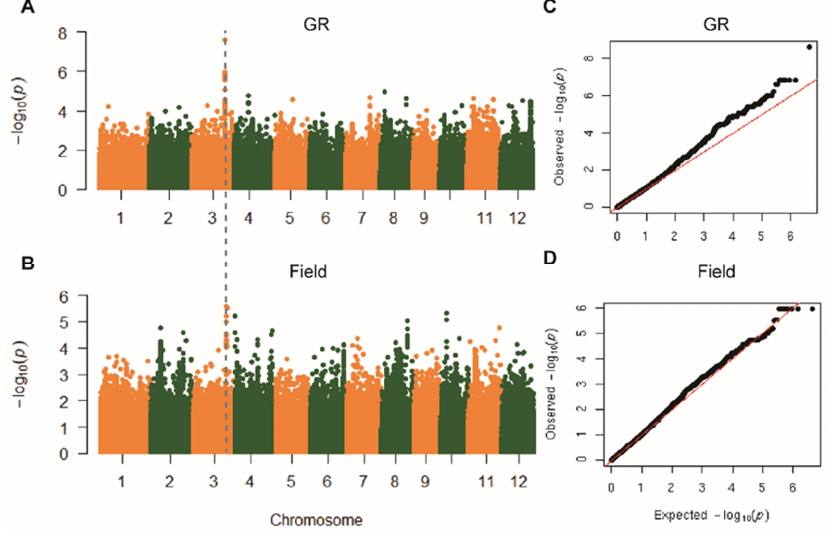
Figure 2. Genome-wide association study (GWAS) performed on the R d trait under GR and field conditions. ( A ) and ( B ) Manhattan plots from the associate mapping of R d using a linear mixed model (MLM) in GR and field, respectively. ( C ) and ( D ) QQ plots of expected versus observed P- values of R d in GR and field, consecutively. The vertical dashed-line crossing both Manhattan plots at Chr.3 represents the overlapped genomic regions of significantly associated SNPs for both conditions (GR and field).